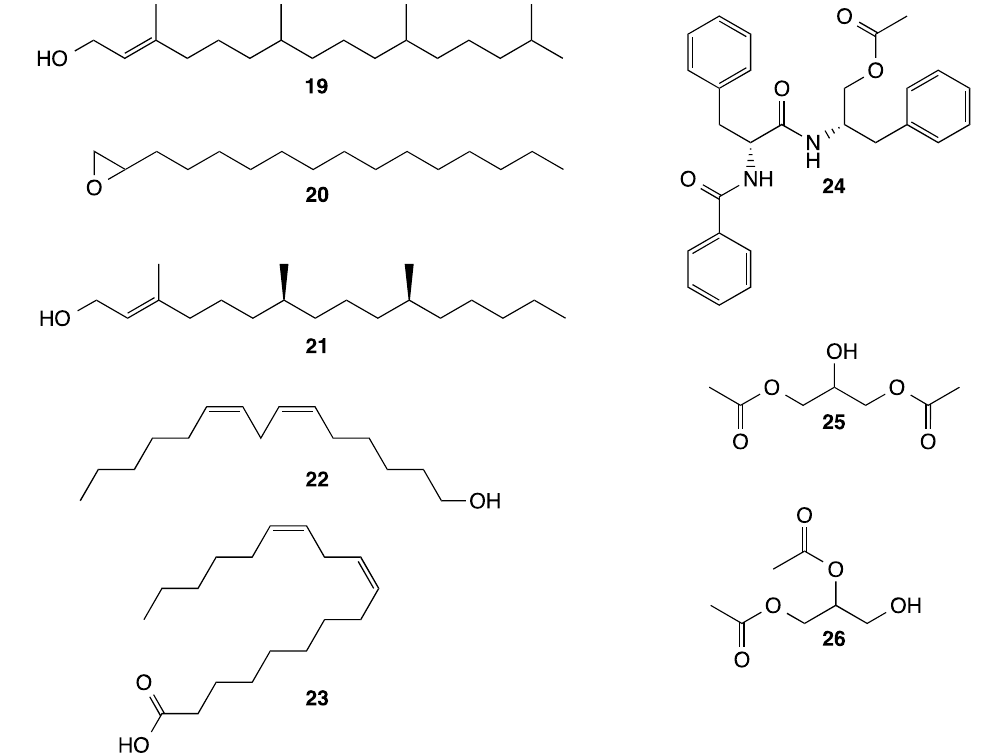
Figure 10. (conti.). Molecular structure of some compounds isolated from species of the genus Figure 10. Molecular structure of some compounds isolated from species of the genus Malachra Malachra L.